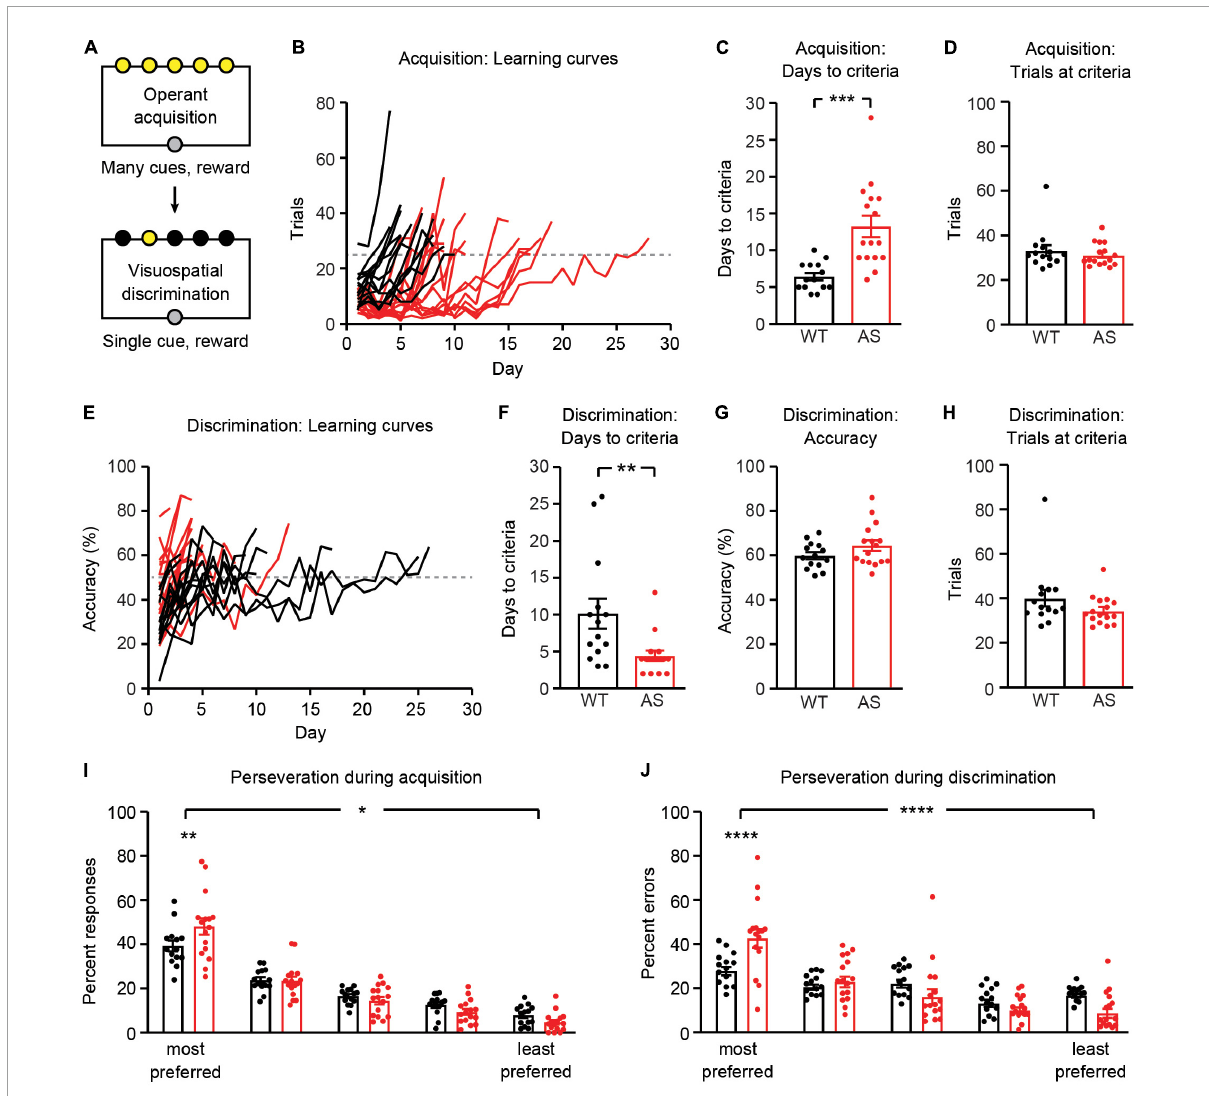
FIGURE3 Ube3a m − / p + mice have abnormal performance during operant acquisition and visuospatial discrimination. WT: black, n = 14. Ube3a m − / p + (AS): red, n = 16. (A) Schematic of operant acquisition and visuospatial discrimination phases. (B) Learning curves during operant acquisition; each line represents one mouse and dotted line represents 25 trial per session threshold. (C) Days to reach operant acquisition criteria ( > 25 trials per session on two consecutive days). (D) Average trials per session on two finals days of operant acquisition, when mice have reached criteria. (E) Learning curves during visuospatial discrimination. Dotted line represents 50% accuracy threshold. (F) Days to reach visuospatial discrimination criteria ( > 25 trials per session and > 50% accuracy on two consecutive days). (G) Average accuracy on two final days of visuospatial discrimination (at criteria). (H) Average trials per session on two final days of visuospatial discrimination (at criteria). (I) Perseveration